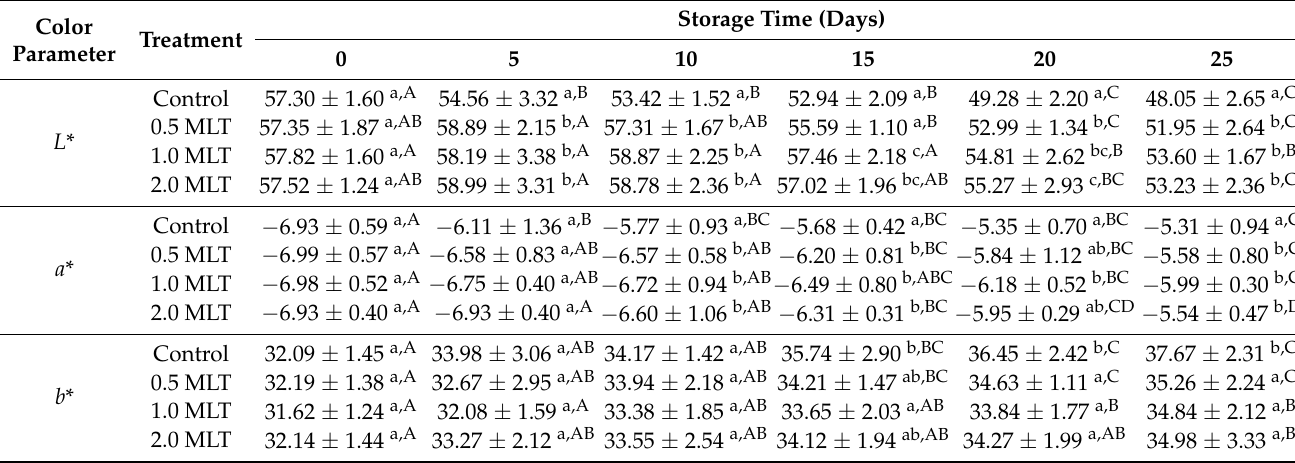
Table 2. Effect of melatonin treatment on color attributes ( L *, a *, b *) of green asparagus during 25 days of storage at 4 ◦ C and 90% relative